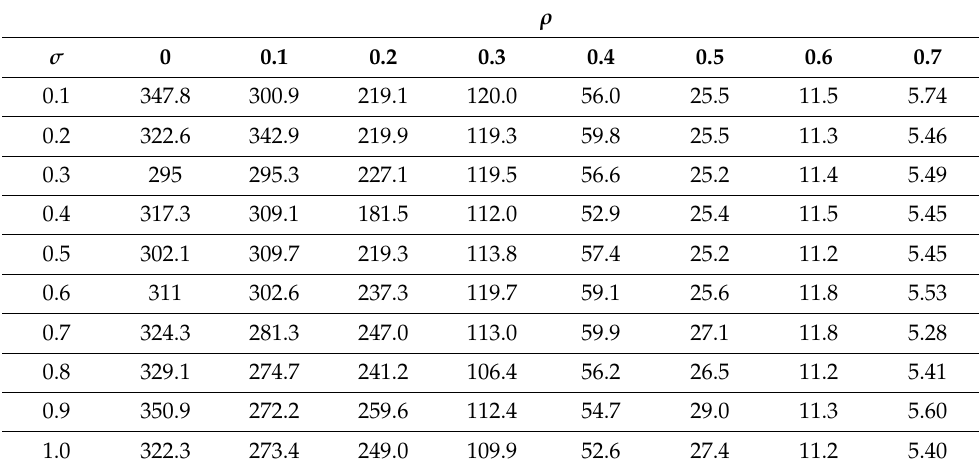
Table 3. Average run length by ρ and σ for the Gaussian Copula.